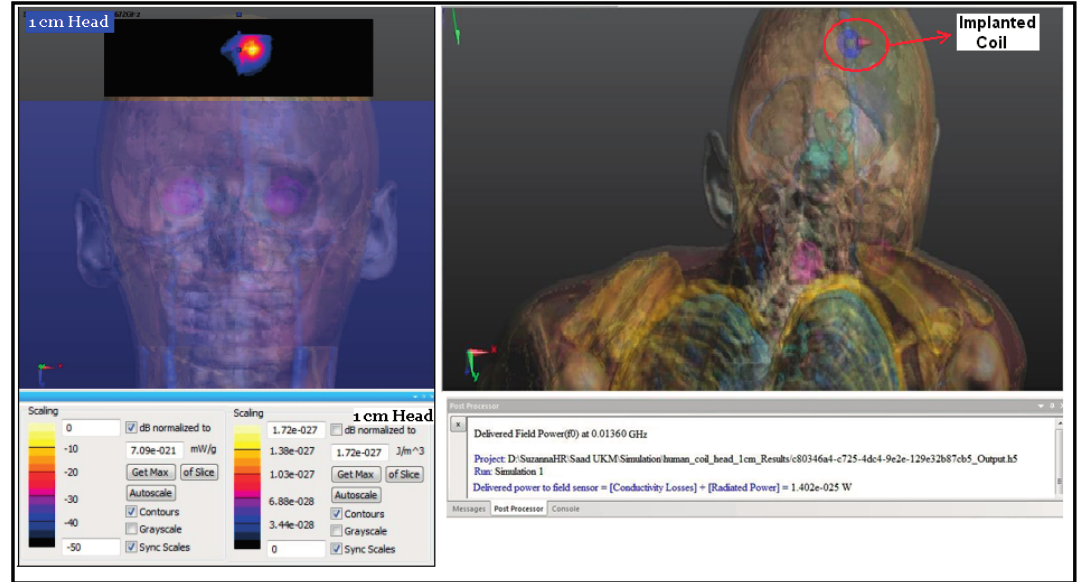
Figure 11. The SAR and power loss in the human body at 13.56 MHz frequency, at a depth of 10